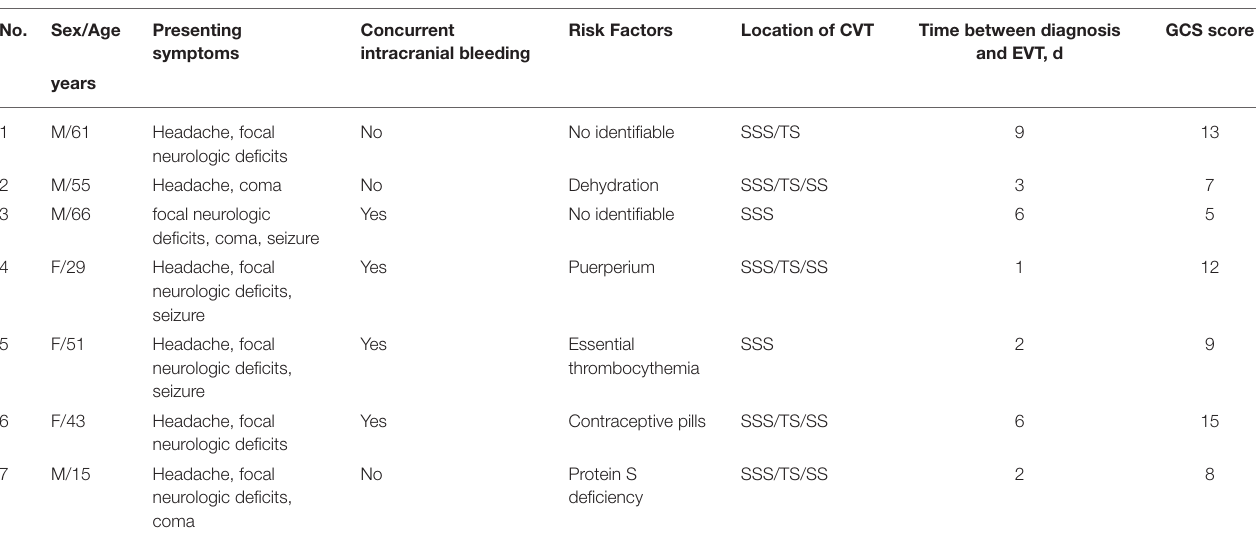
TABLE 1 | Baseline characteristics of the seven patients.